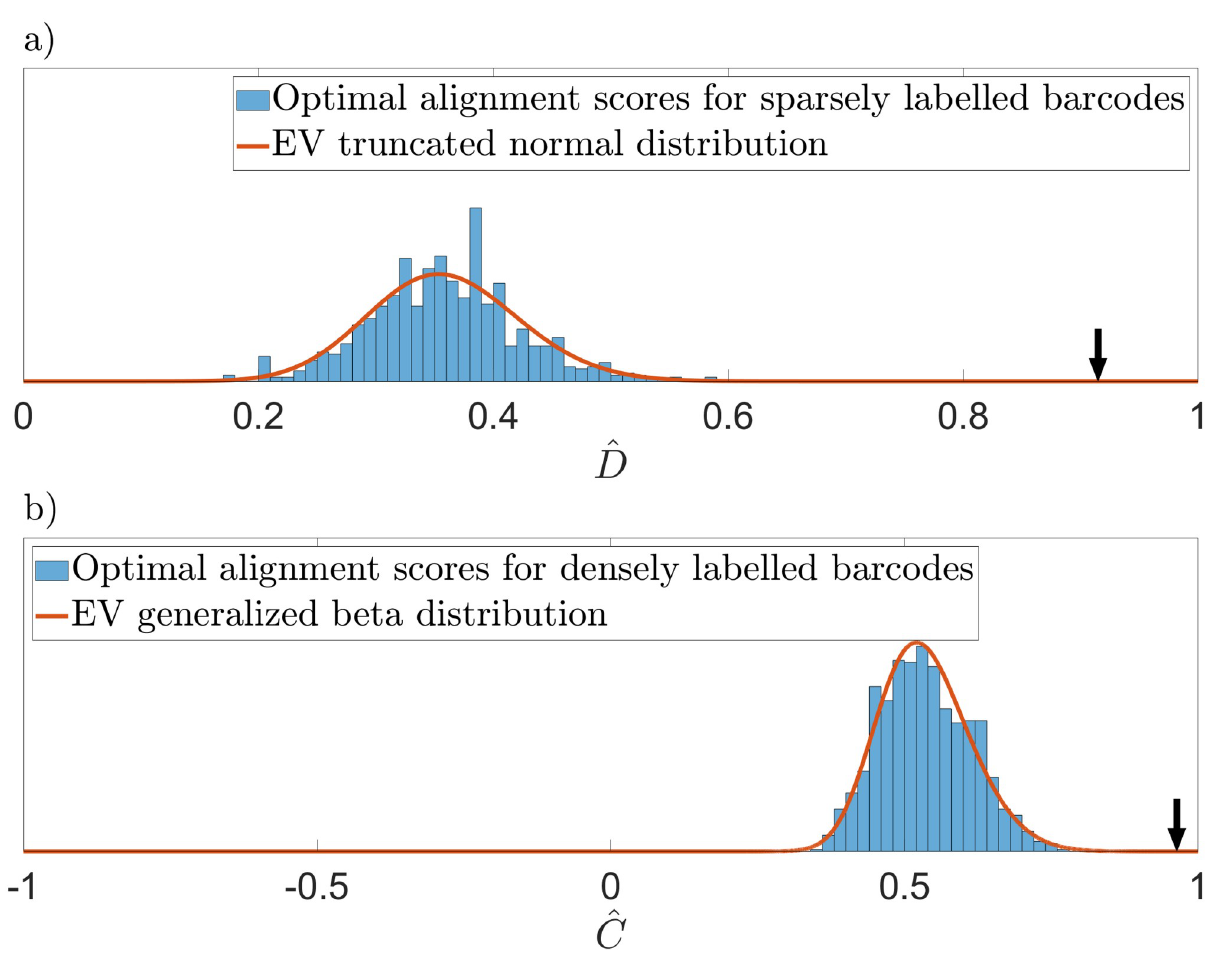
Fig 2. Optimal alignment score histograms obtained by matching to randomized densely- and sparsely-labeled barcodes. In order to generate a null model optimal alignment score histogram we first calculate many randomized barcodes, see S2 Fig for sparsely labeled barcodes and S3 Fig for densely labeled examples. We then calculate the alignment scores between the experimental barcode at hand and these randomized barcodes for every possible orientation and circular shift. Selecting the best score (optimal alignment) gives a score distribution that can be fitted to an extreme value distribution. (a) Optimal alignment score distribution for sparsely labeled barcodes. (b) Optimal alignment score distribution for densely labeled barcodes. Using these fitted distribution, we then convert any observed optimal alignment score to a match score Z and a p-value, as described in sec 2.4.2. The arrows in the two panels indicate the observed optimal alignment scores for the cases shown in Fig 4. Since these optimal alignment scores are far out in the tail of the distribution (p-values = 2 � 10 − 10 and 7 � 10 − 12 , respectively), the optimal alignment scores in that figure are deemed to be significant. S4 Fig gives the distributions for all alignment scores (not just the